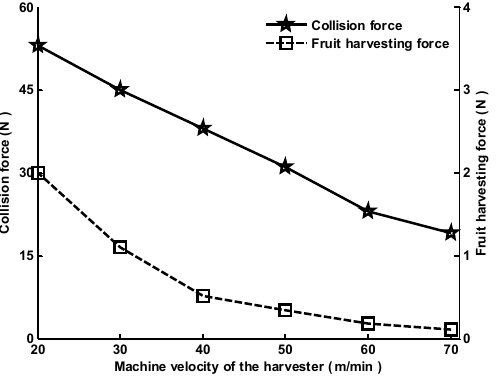
Figure 20. The variation curves of the influence of the machine velocity of the harvester. The variation tendency of the curves in Figure 19 was observed and calculated by Equation (14). The F-test value F xy of the curves of collision force and the curves of fruit harvesting force in Figure 20 was 2.17, which was smaller than the corresponding standard value F 0 : 9.552. Thus, the curves were not significantly different, which indicated that the curves of collision force machine velocity of the harvester and the curves of fruit harvesting force-machine velocity of harvester had a high degree of relevance. In other words, both the collision force and the fruit harvesting force resulting from the interaction between the finger rows of the harvester and the blueberry branch were inversely proportional to the machine velocity of the